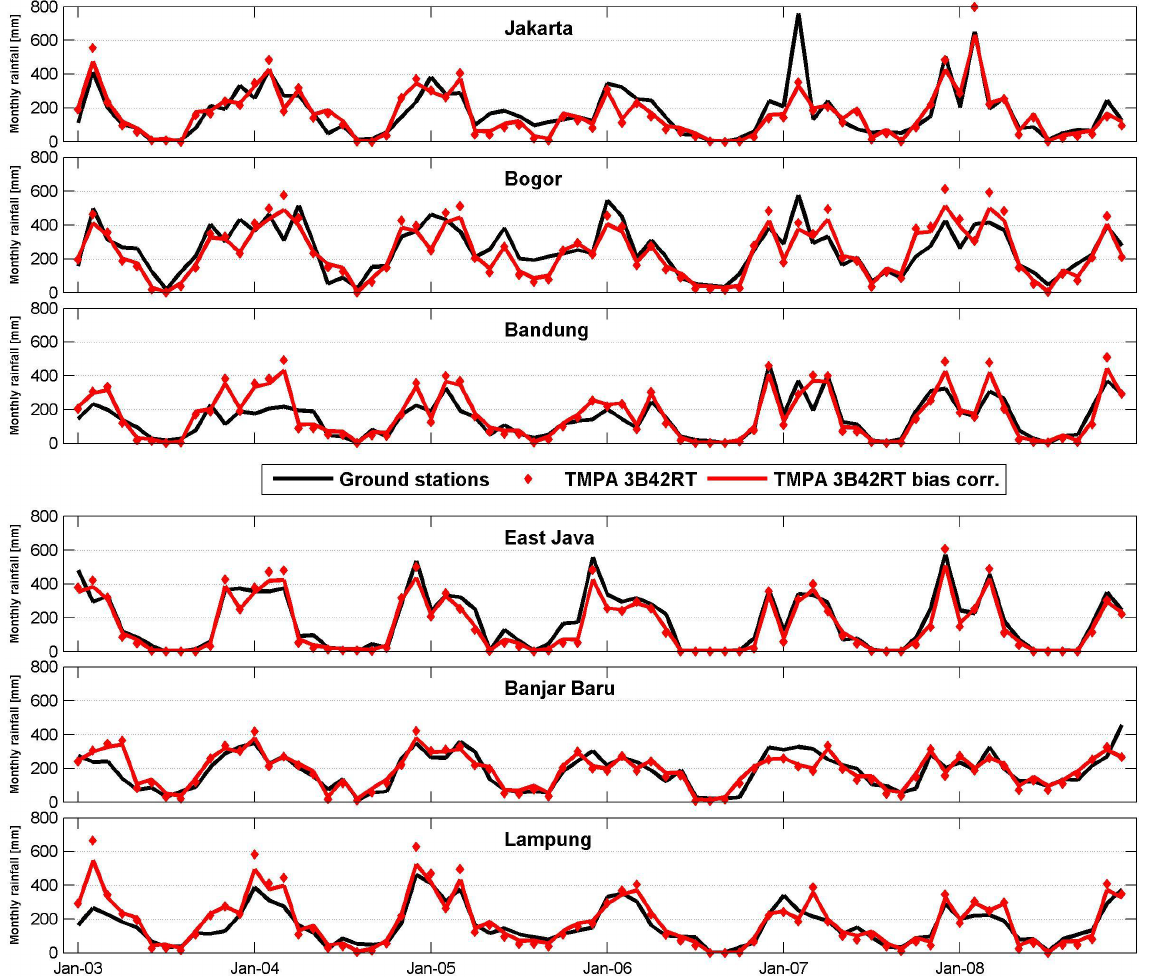
Fig. 8. Comparison of average monthly ground station rainfall with bias corrected and uncorrected TMPA 3B42RT for the individual validation areas.